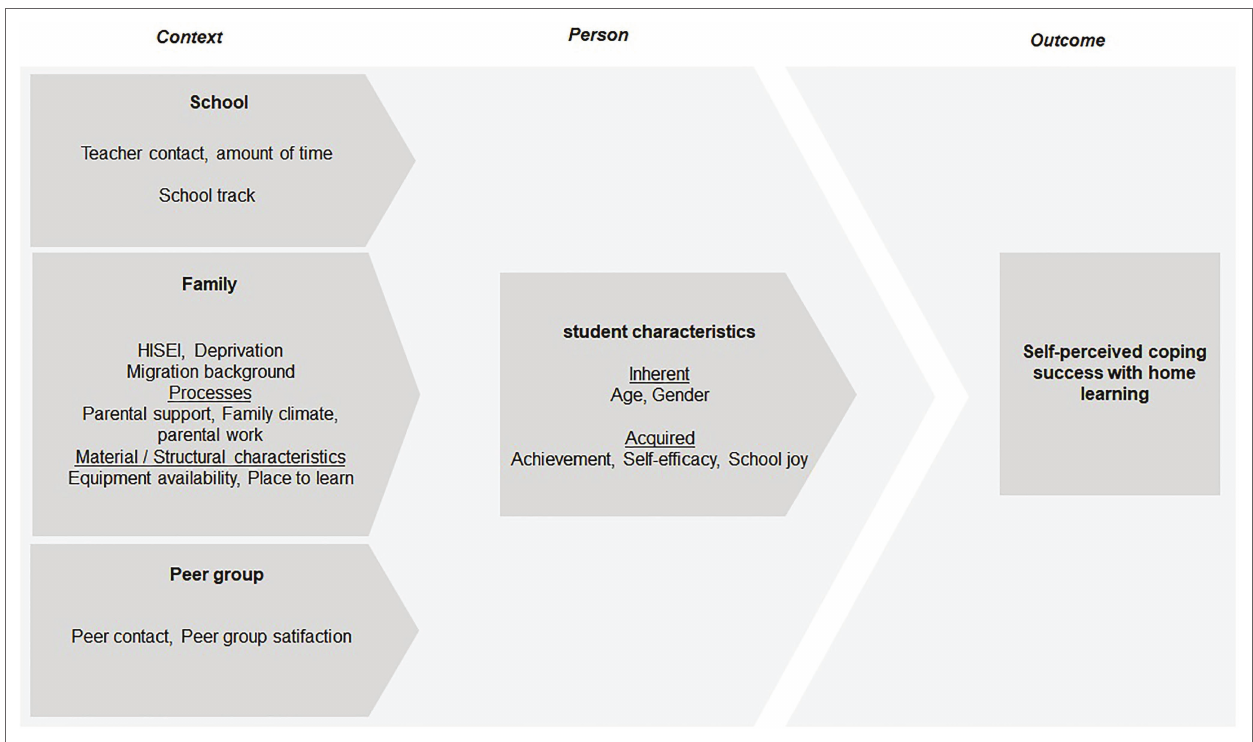
FIGURE 2 | Operationalising